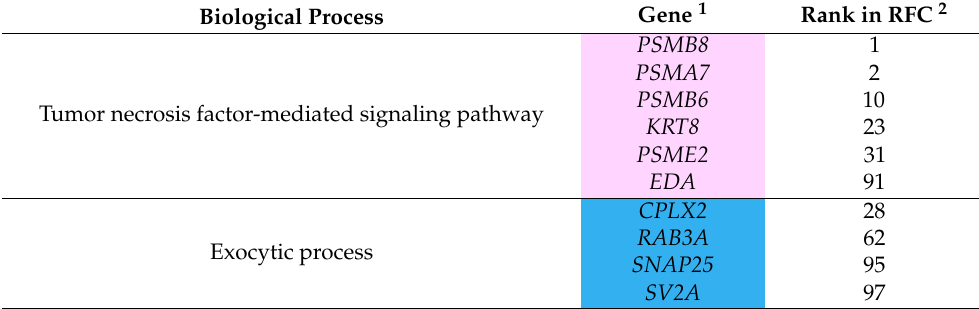
Tumor necrosis factor-mediated signaling